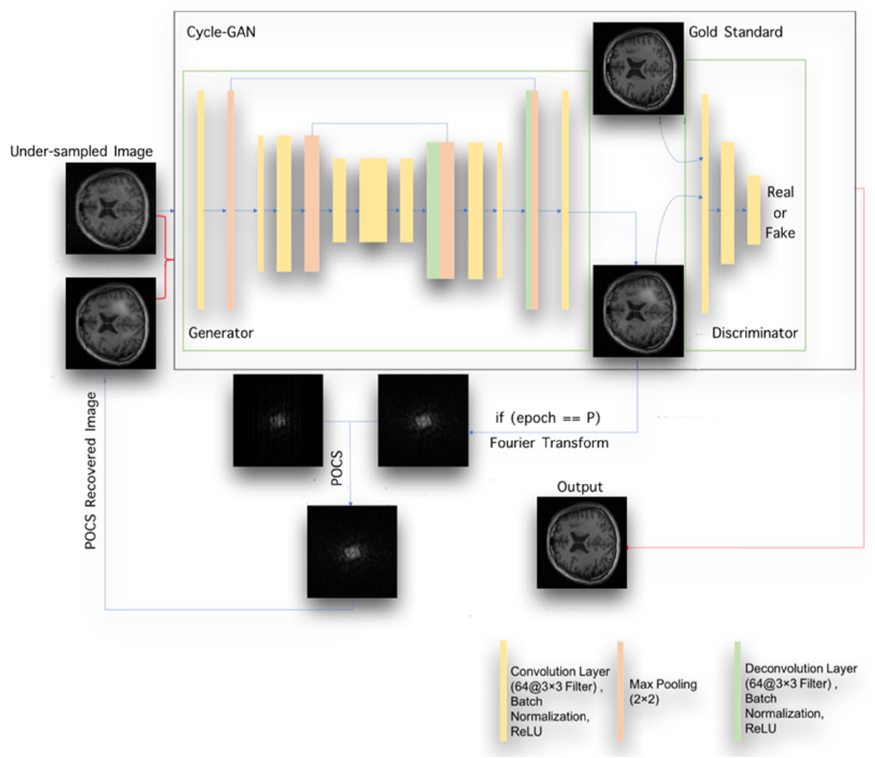
Figure 1. A schematic view of the POCS-augmented Cycle-GAN. The entire algorithm contains two recursive processes. Each has the same network structure but a different number of training samples. The output of the first process is used as new training samples in addition to the original training data after the following POCS reconstruction. The output of the first process is first inversely transformed into the Fourier domain. Then, the data of the sampled locations in the Fourier domain are replaced with the acquired ones, and the manipulated Fourier domain data are transformed back to the image domain. The generator is composed of a U-Net (Hyun et al., 2018) with skip connections. The discriminator uses a convolutional neural network. The functions of different layers are denoted by the legends at the bottom of the